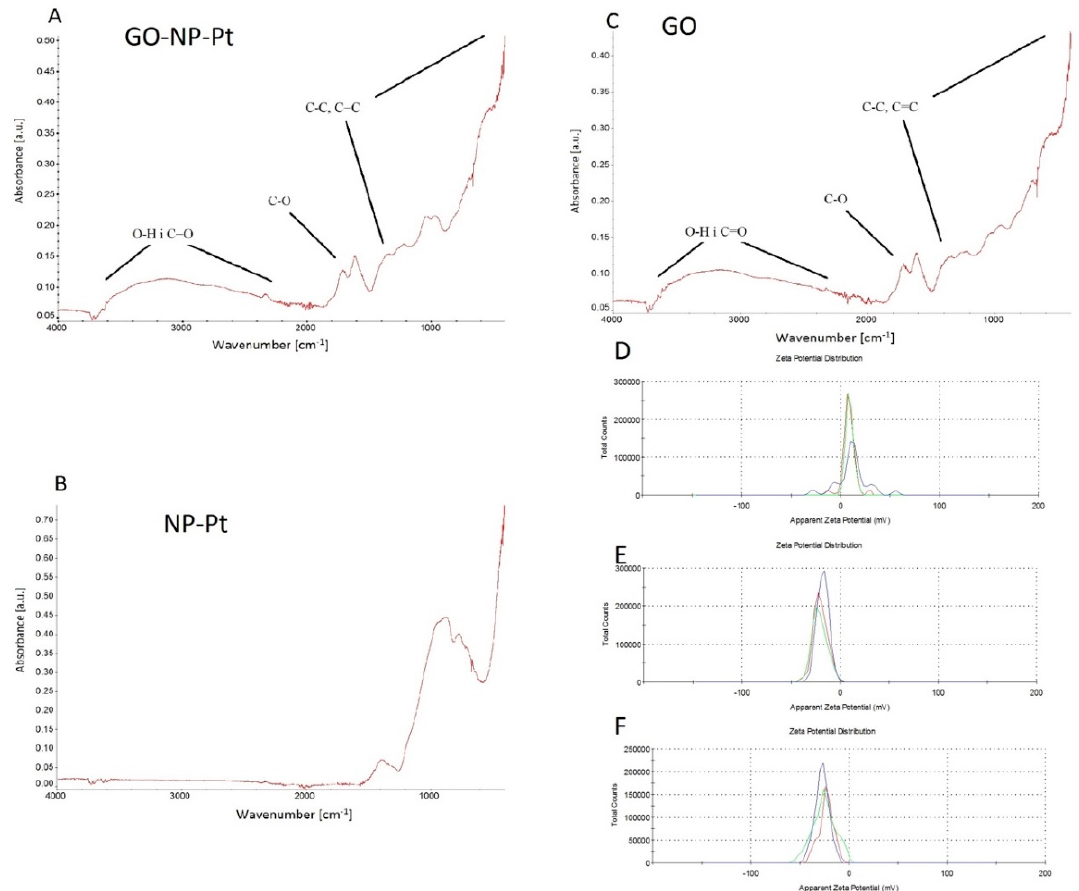
Figure 2. FTIR spectrum and ζ -potential of nanocomplexes of ( A , D ) graphene oxide and platinum nanoparticles, ( B , E ) platinum nanoparticles, and ( C , F ) graphene oxide. Abbreviations: GO-NP-Pt—nanocomplexes of graphene oxide and platinum nanoparticles, NP-Pt—platinum nanoparticles, GO—graphene oxide.